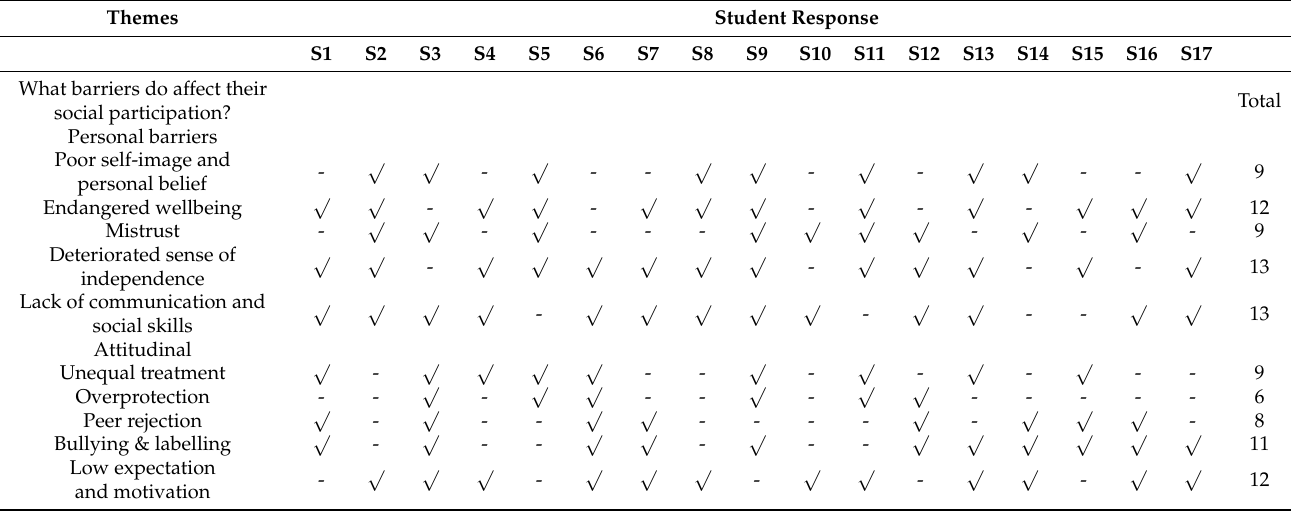
Table A2. Participants’ responses and frequency of themes. SVIs interview responses: What